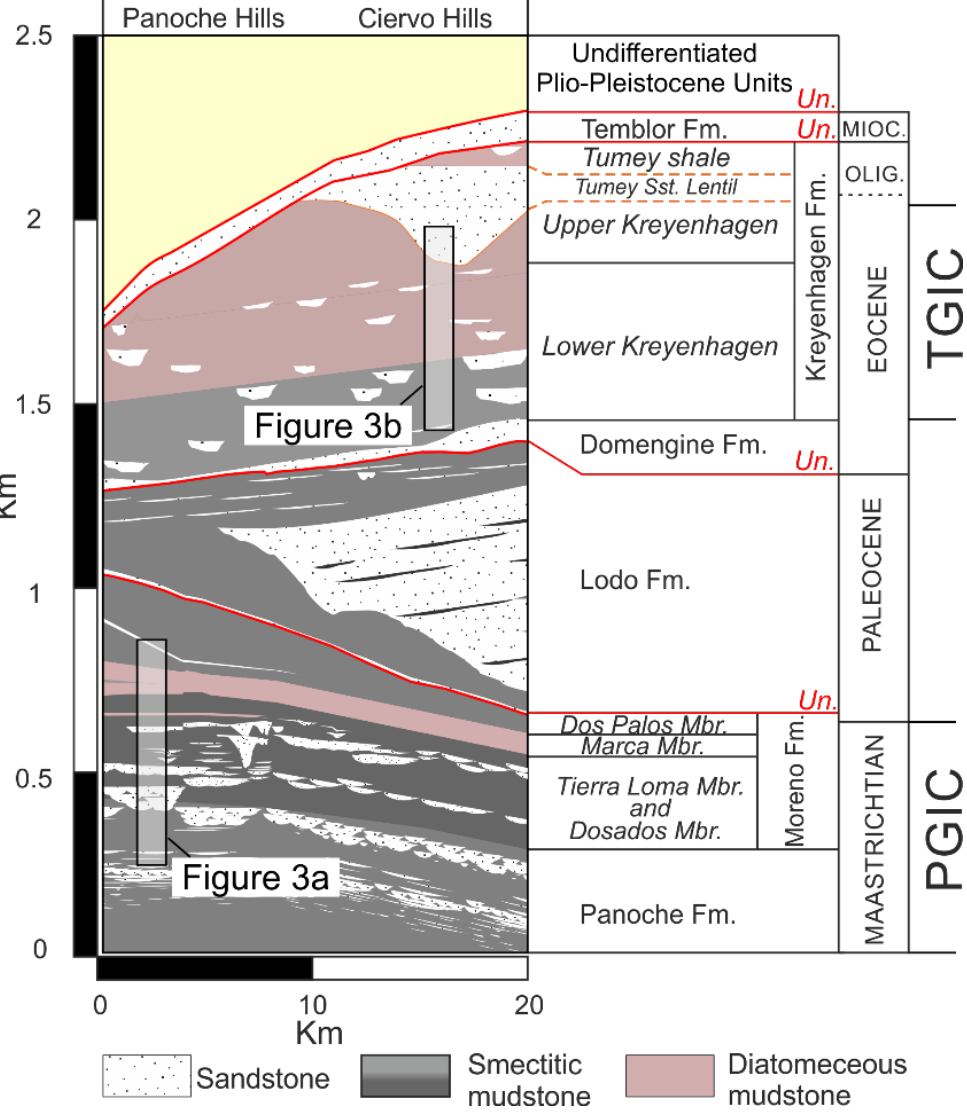
3.1. Materials Mudstone samples were collected from transects through the outcrop of the Upper Cretaceous to Lower Paleocene Moreno Formation (1) and the Eocene of the Kreyenhagen